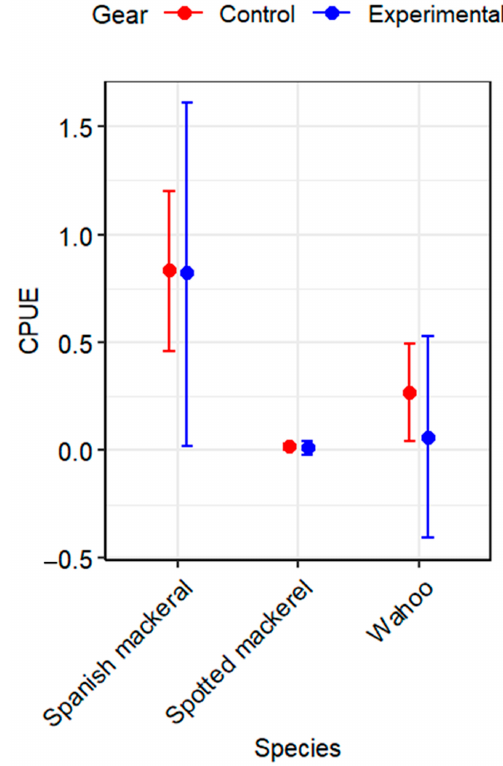
Figure 3. Mean CPUE (number of fish caught per h for webbing) of narrow-barred Spanish mackerel, spotted mackerel, and wahoo caught by control (red) and experimental (blue) gillnets. Points represent mean catch. Bars are 95% confidence intervals. Negative confidence intervals indicate that they are not statistically significant.